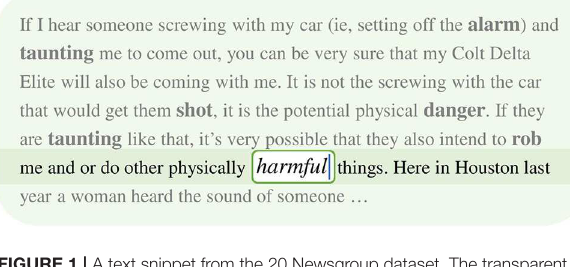
FIGURE 1 | A text snippet from the 20 Newsgroup dataset. The transparent part represents the local context of the word “harmful.” The semitransparent part denotes the remainder of the